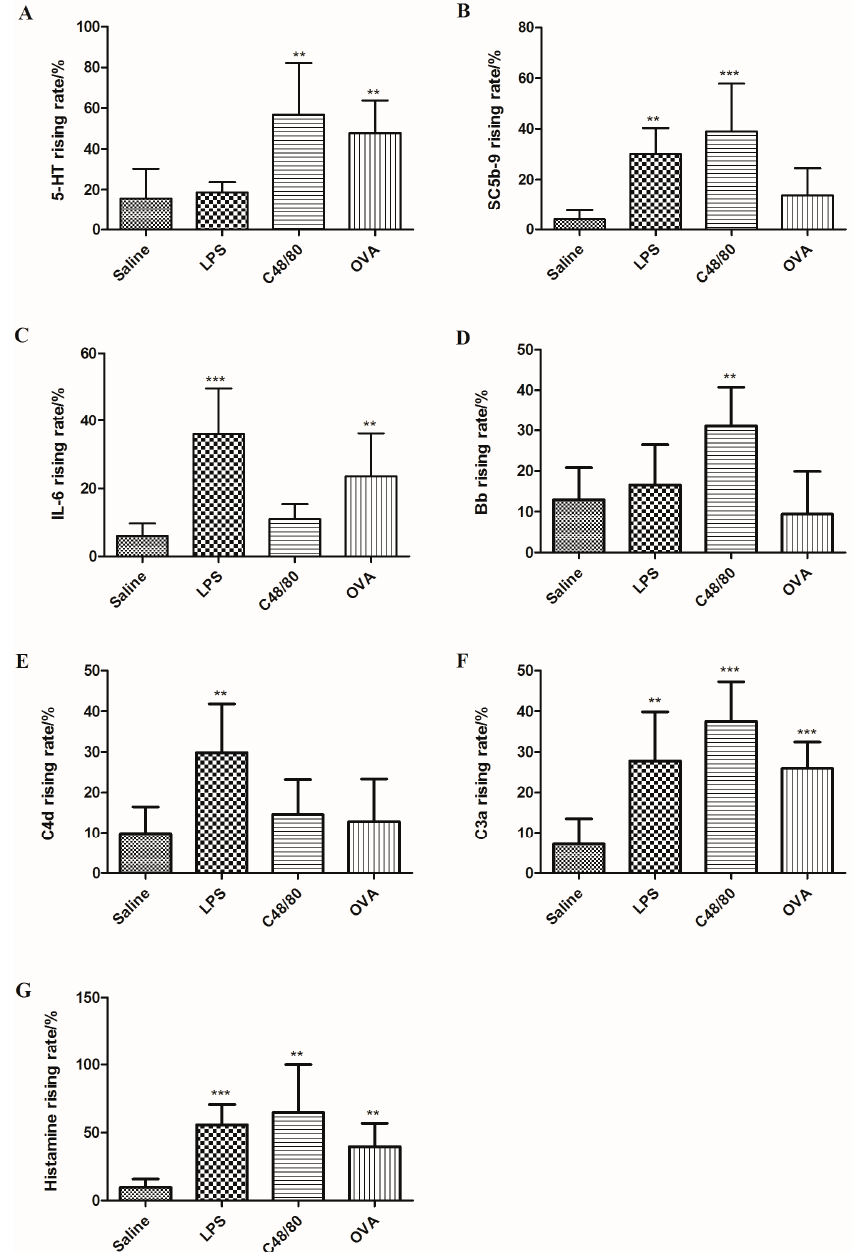
Figure 4. Rising rates of 5-HT, SC5b-9, IL-6, Bb, C4d, C3a and histamine in plasma after treated